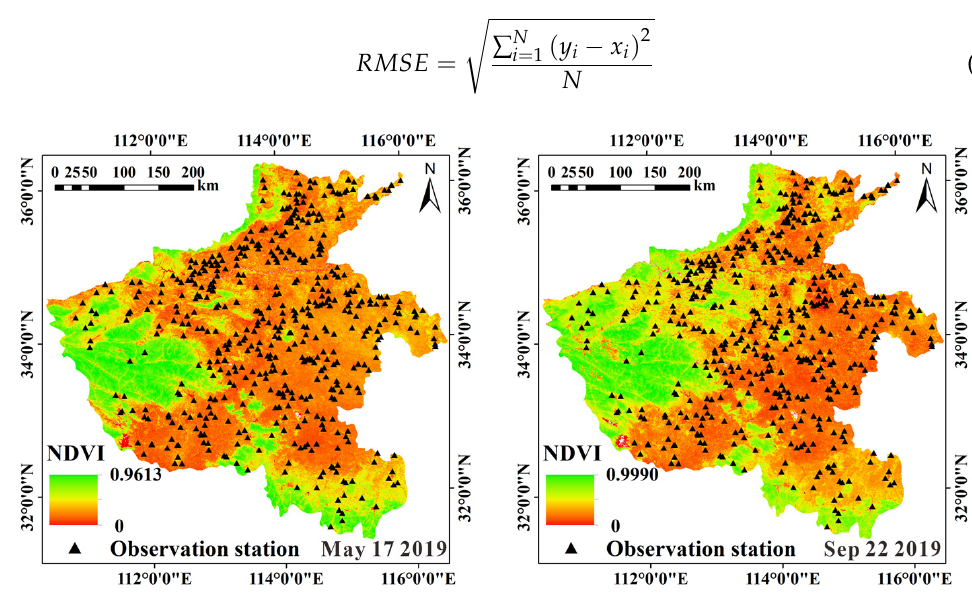
Figure 4. Distribution of NDVI in the study area.